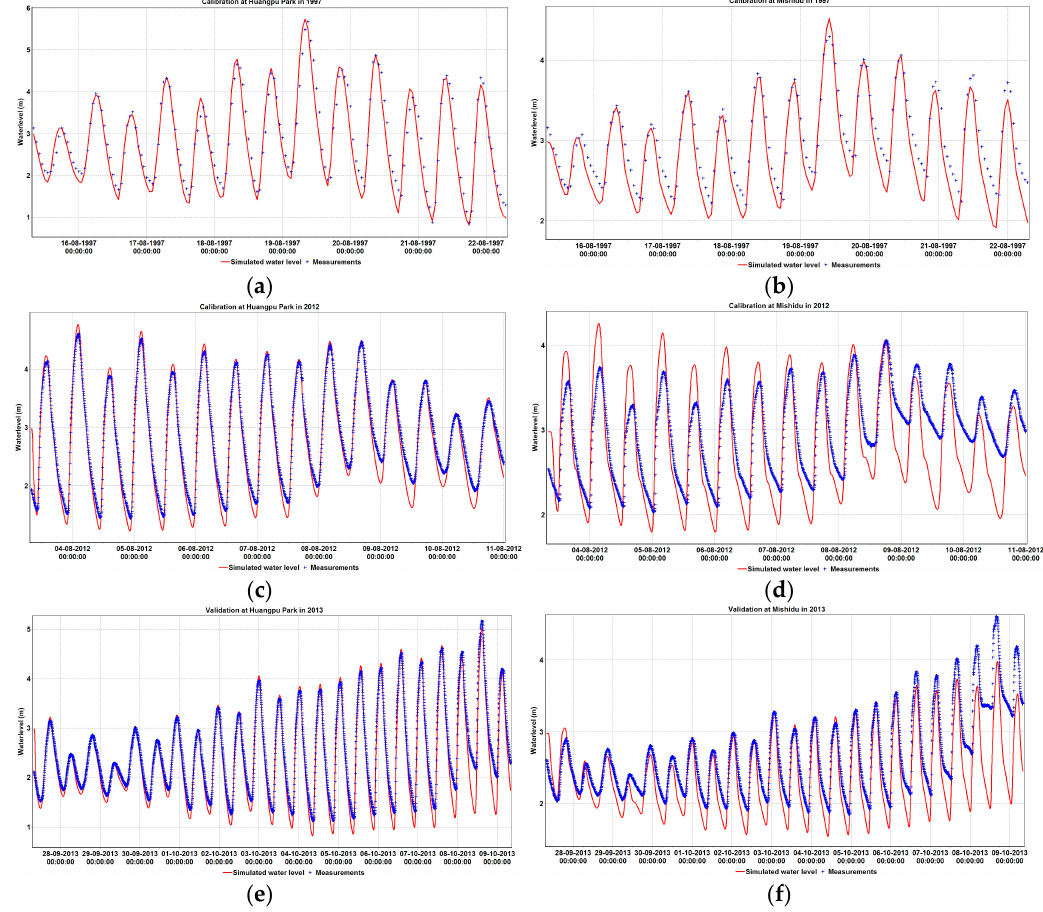
Figure 3. Calibration results of water levels at Huangpu Park and Mishidu, ( a , b ) in 1997 and ( c , d ) in 2012; validation results of water levels at Huangpu Park ( e ) and Mishidu ( f ) in 2013. In each plot, red line is model result, and blue dots are gauge measurements.